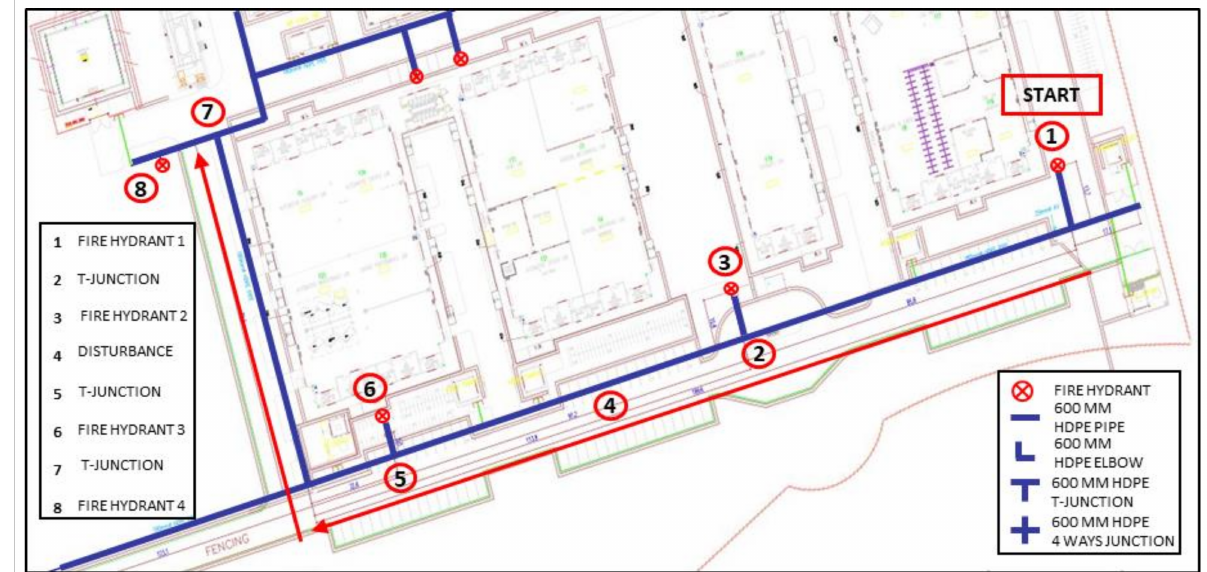
Figure 5. Fire Hydrant 1: Solenoid Valve and Pressure Sensor fitted at the point of analysis (Figure 6).